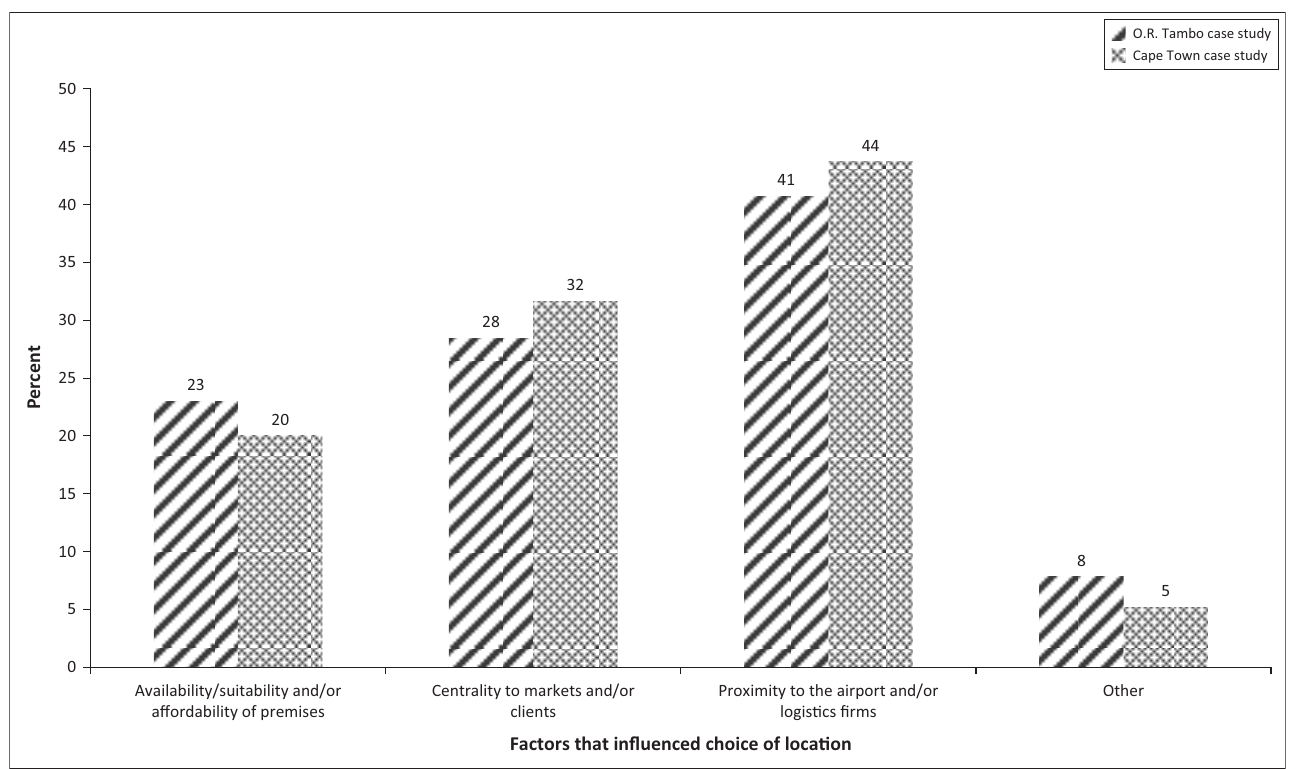
FIGURE 3: Factors that influenced the airport-centric firms’ choice of